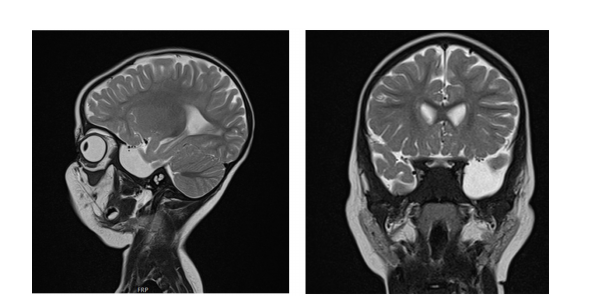
FIGURE5 Brain MRI of patient six at the age of 2 years. T2 sagittal and coronal MRIs show an arachnoidal cyst in the left temporal region and atrophy of the left temporal